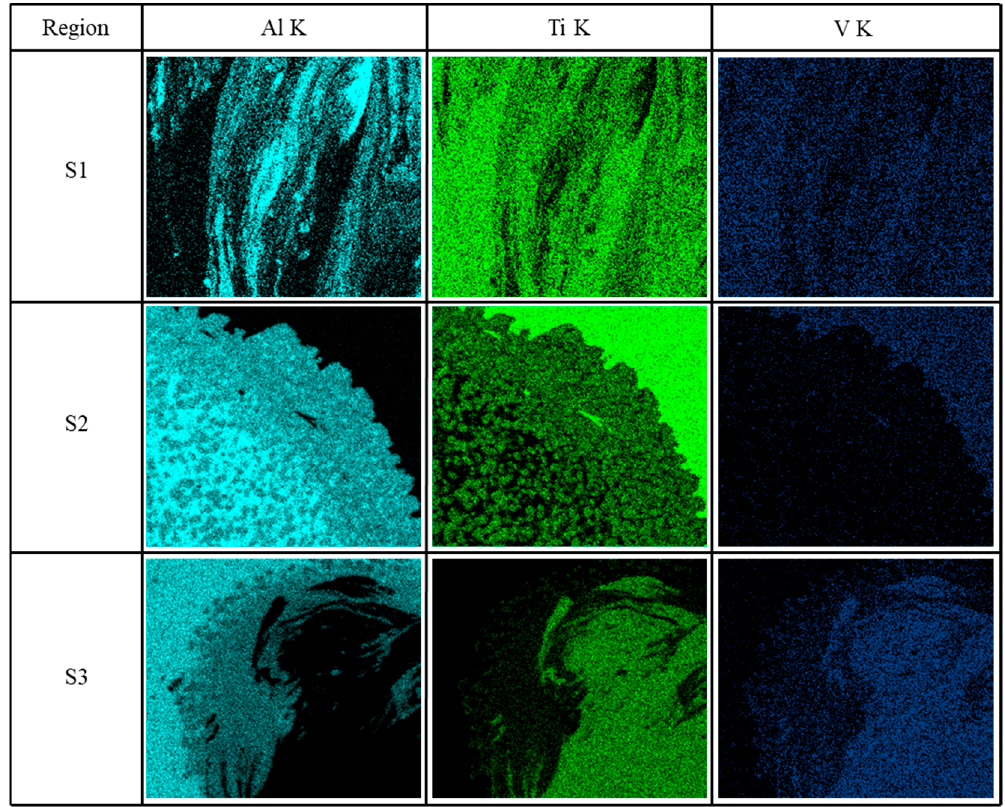
Figure 5. Energy dispersive spectrometry (EDS) element distribution maps of selected regions in the stir zone (red square marked in Figure 4a).